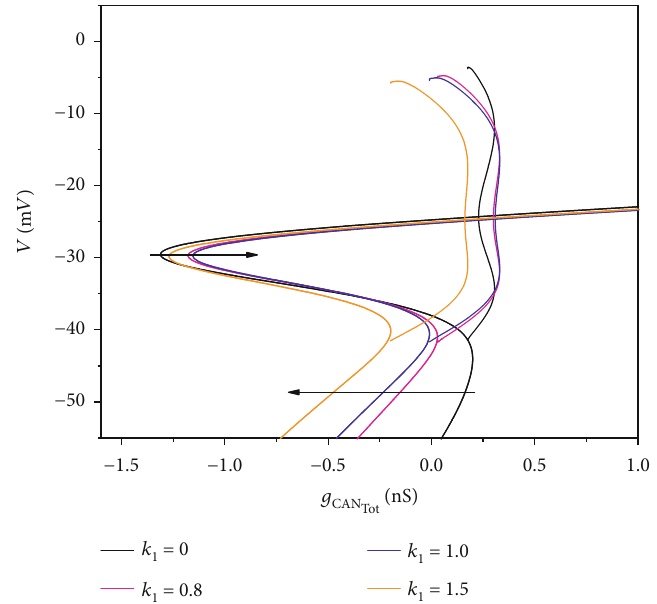
Figure 12: The e ff ect of k on the bifurcation diagram. The black curve is the bifurcation curve when k 1 bifurcation curve when there is no external stimulus. The color curves are the bifurcation curves with a nonzero external stimulus. Corresponding values of k are marked in the upper right corner of the fi gure. 1